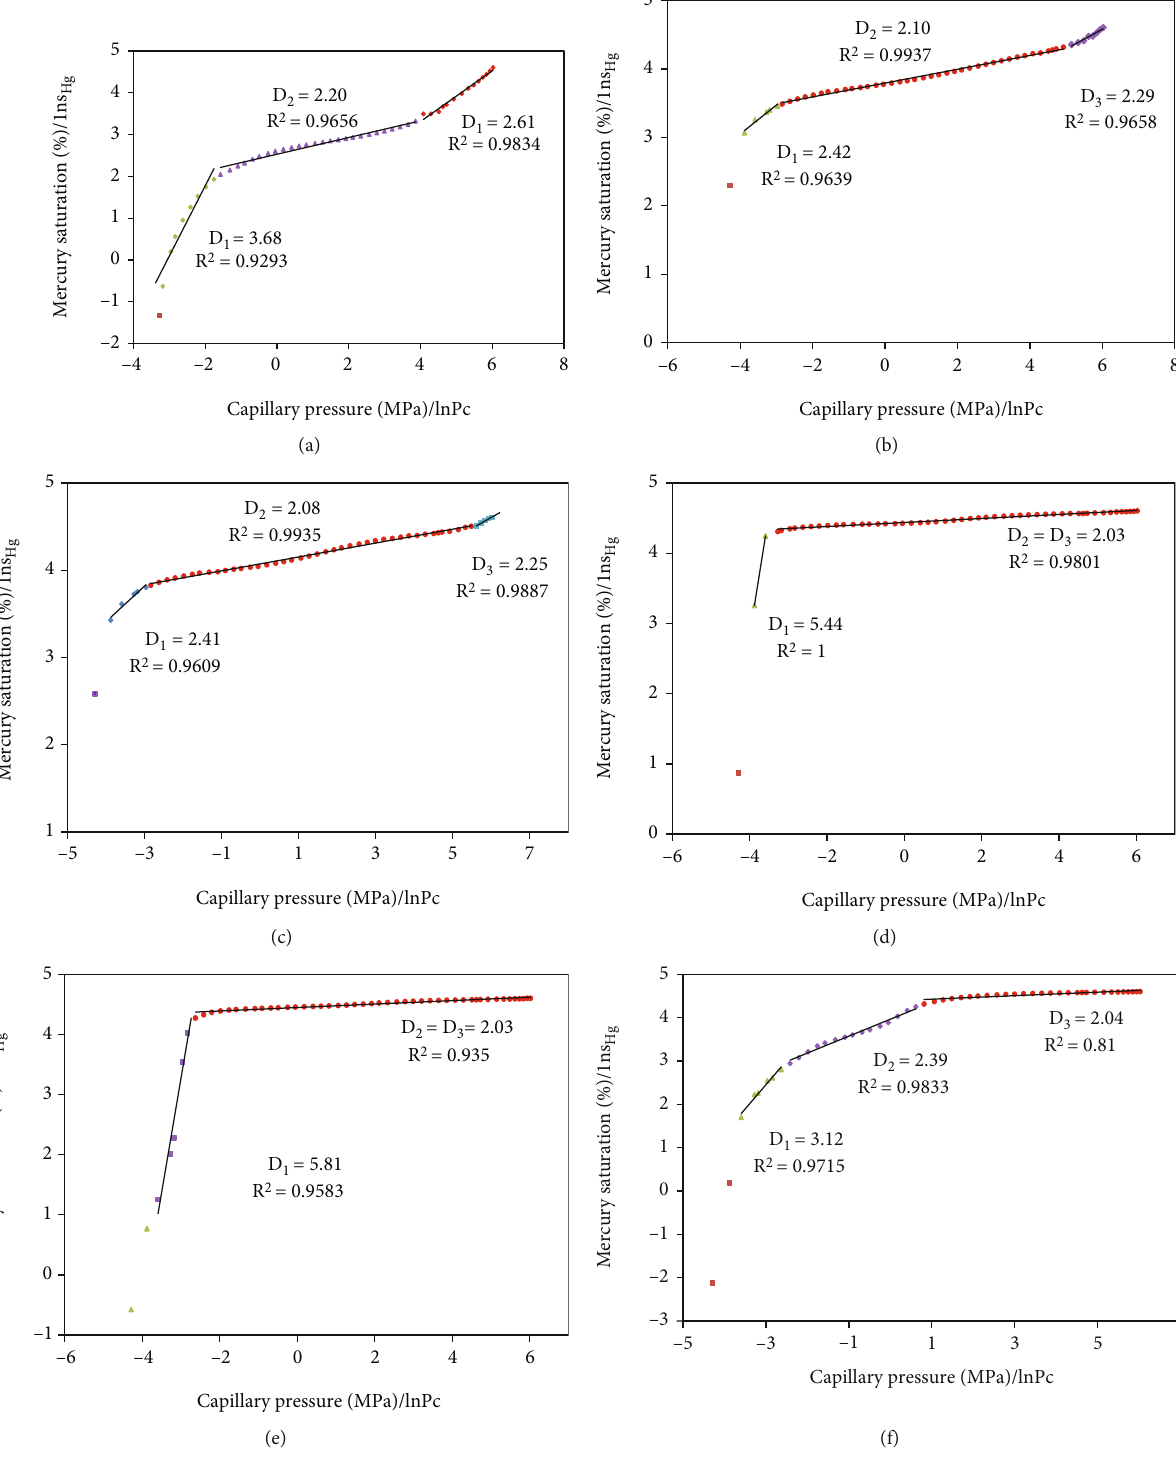
Figure 8: Fractal dimensions of shale samples with di ff erent particle sizes: (a) 5000 μ m; (b) 2915 μ m; (c) 550 μ m; (d) 210 μ m; (e) 102 μ m; (f) 27 μ